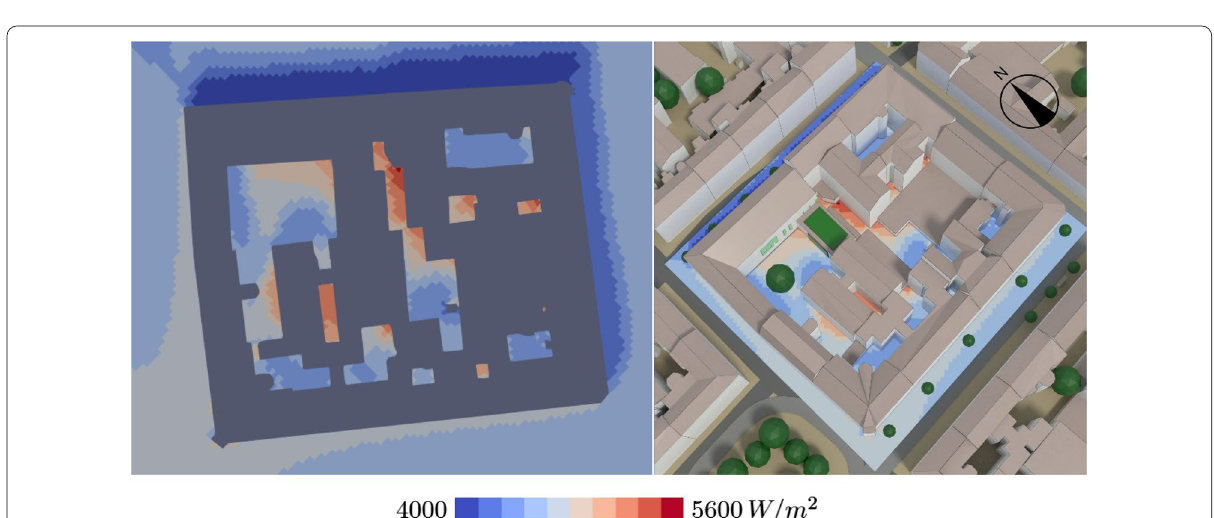
Fig. 19 Radiation density of the simulation case Kandlgasse, 1.5 m above the ground at 14:00 CEST on 01 August 2017, shown as spherical integral over all spatial